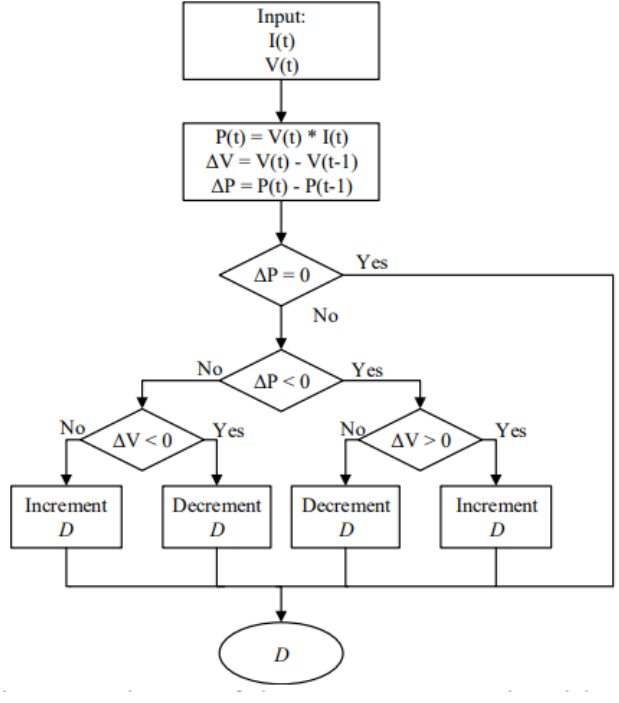
Figure 1. Scheme of the MPPT-P&O